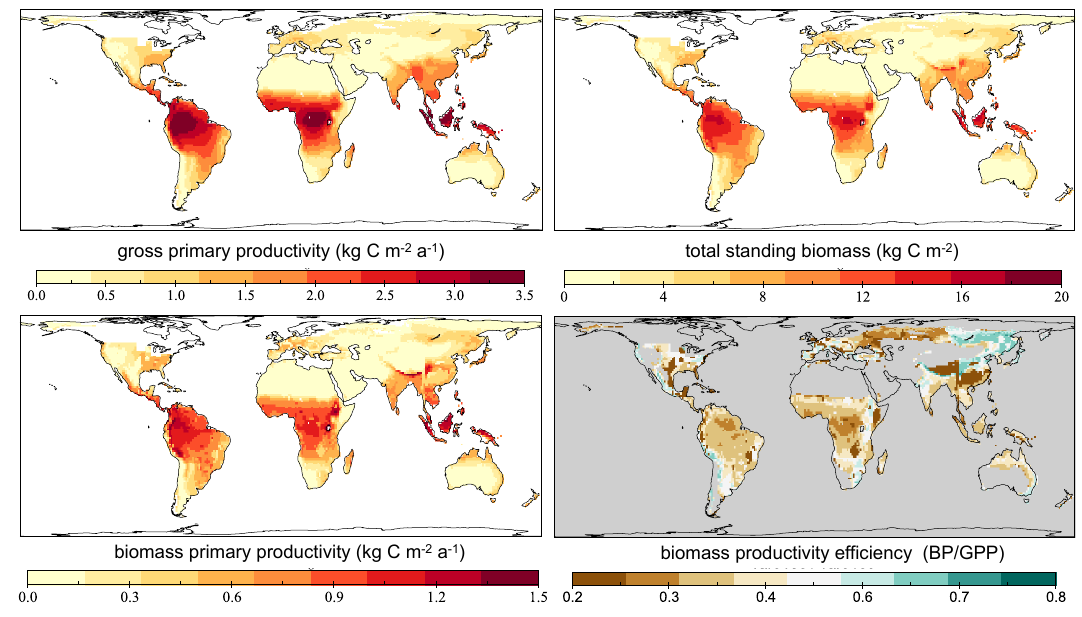
Figure 11. Carbon fluxes and pools in vegetation considering active P vegetation uptake after 70000yr of soil evolution.